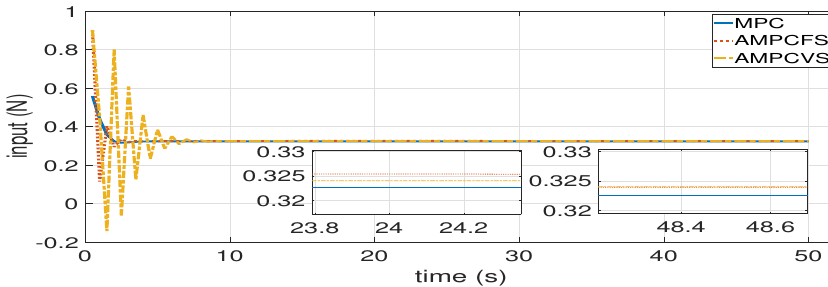
Figure 6. The speed profile of train with different MPC systems.